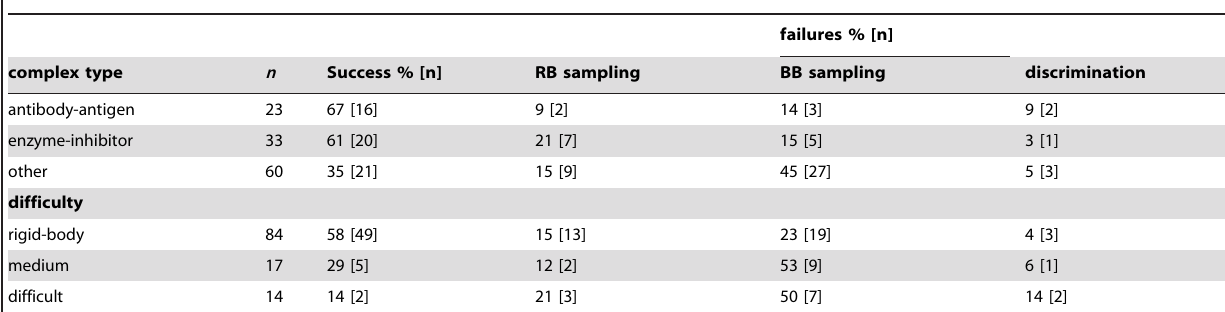
Table 4. Docking success and failure by complex type and